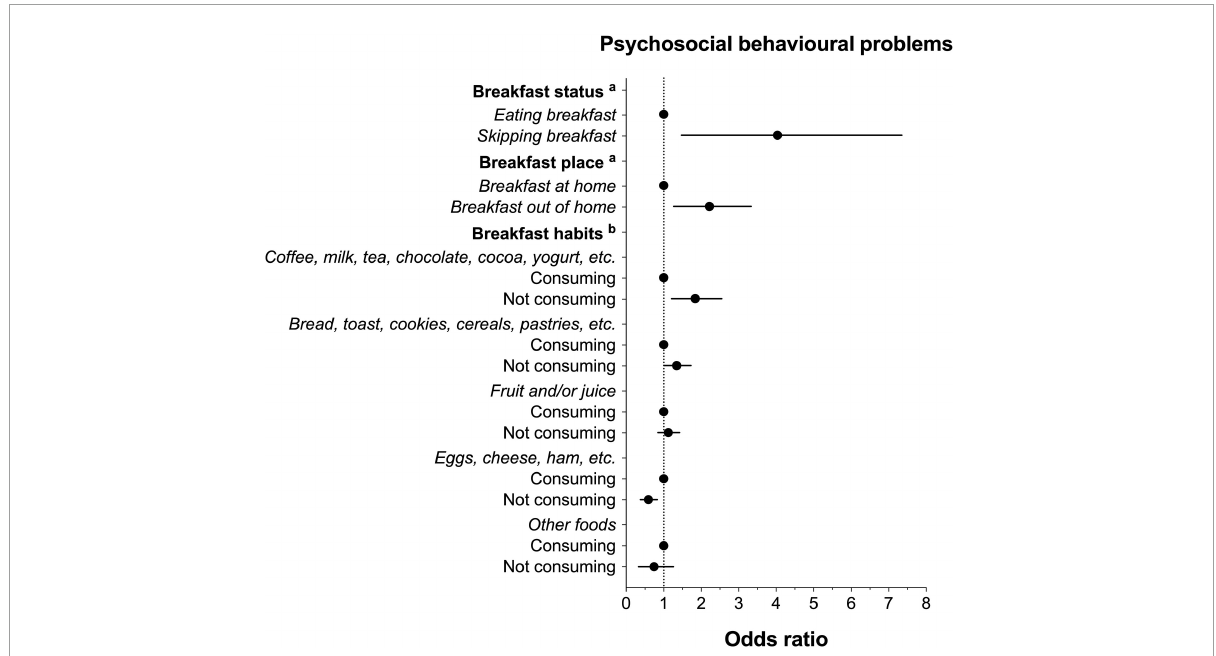
FIGURE3 Odds of psychosocial behavioural problems according to breakfast status, place and habits. Data expressed as odds ratio (dots) and standard error (bars). No psychosocial behavioural problems group was considered as the reference category. Adjusted by age, sex, region, social class, immigrant status, excess weight, physical activity level, recreational screen time, sleep duration, and Spanish Healthy Eating Index score. a Analyses were further adjusted by breakfast habits. b Analyses were also adjusted for the remaining possible breakfast habits (i.e., the consumption of "coffee, milk, tea, chocolate, cocoa, yoghurt, etc." was further adjusted for "bread, toast, biscuits, pastries, etc.," "fruit and/or juice," "eggs, cheese, ham, etc.," and "other